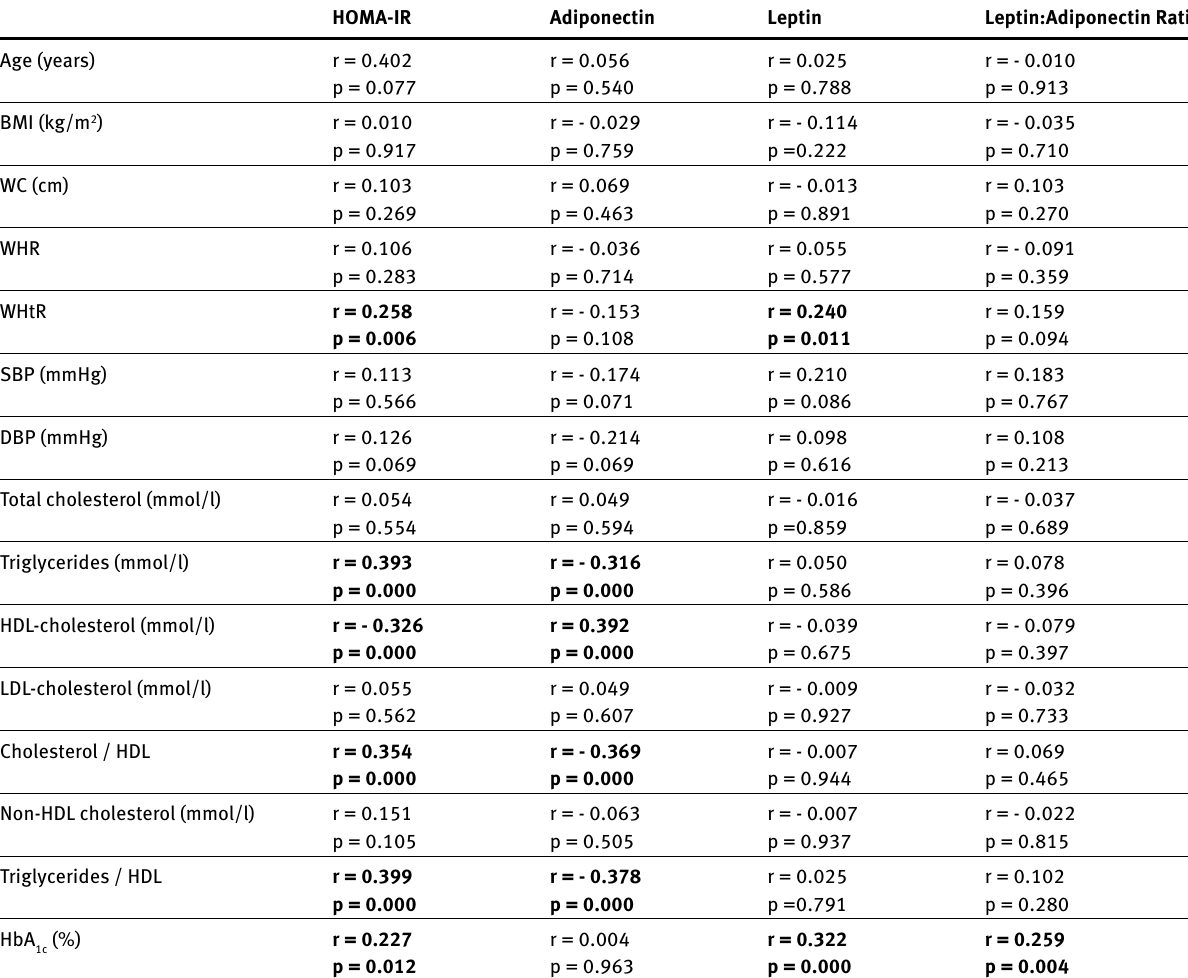
Table 2: Correlations of clinical and biochemical data with HOMA-IR and adipokine values